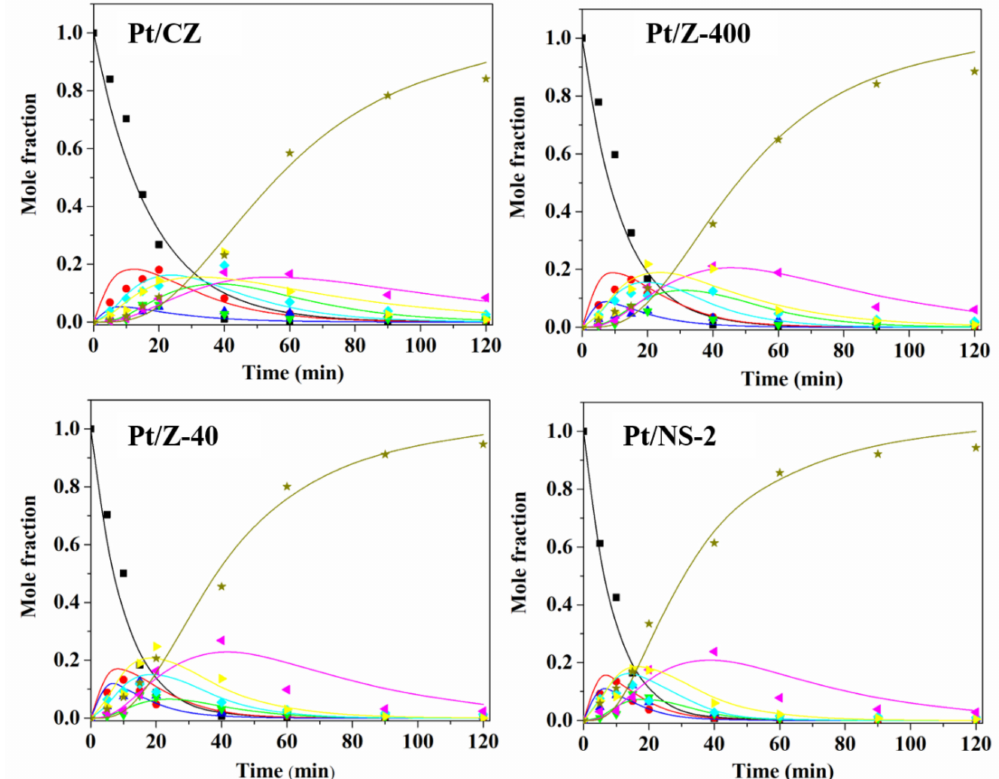
Figure 9. Mole fractions of various products in the reaction mixture obtained at di ff erent residence times and temperature of 250 ◦ C. The points denote the experimental data, and the lines represent the calculatedvalues:( )Guaiacol, ( )2-Methoxycyclohexanone, ( )Phenol, ( )2-Methoxycyclohexanol, ( ) Cyclohexanone, ( ) Cyclohexanol, ( ) Methoxycyclohexane, ( )